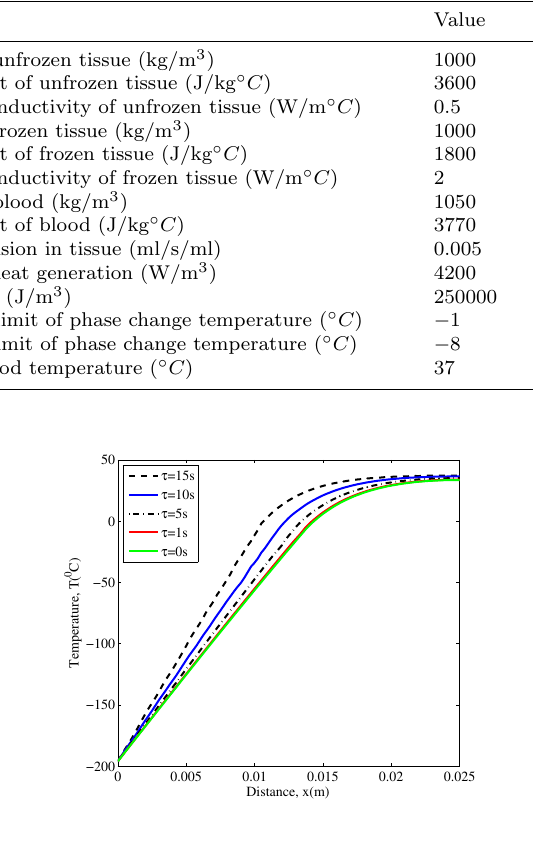
Figure 2. Temperature profile at t = 400 s for the value of τ = 15 s , τ = 10 s , τ = 5 s , τ = 1 s , τ = 0 s